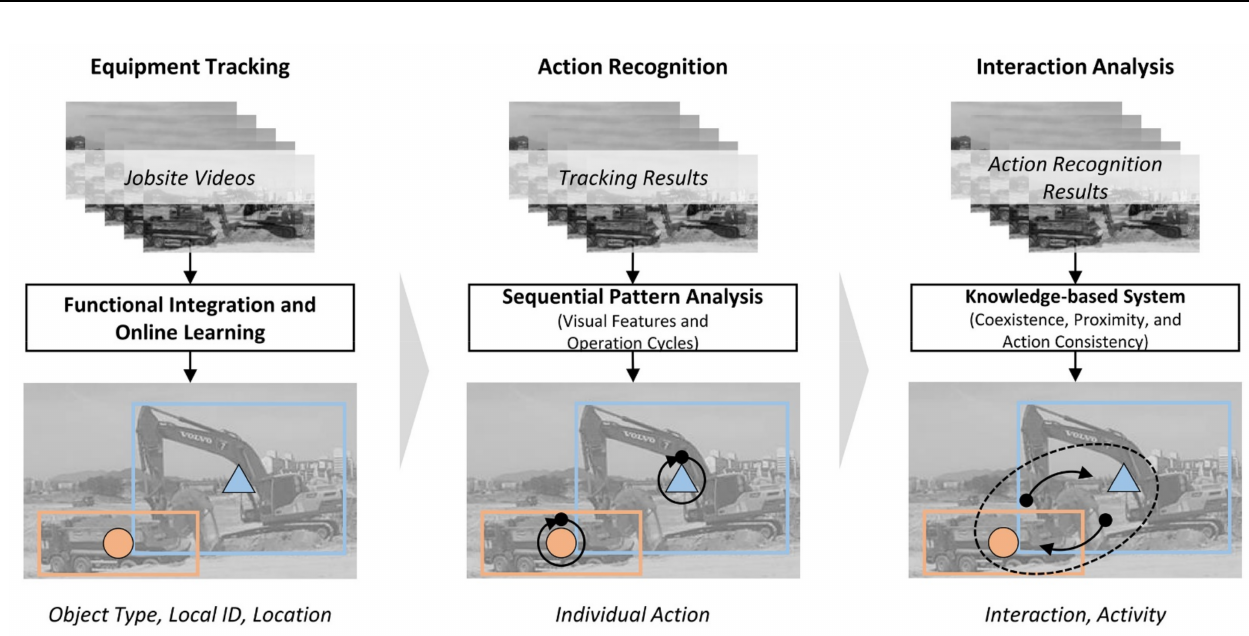
Figure 6. Equipment tracking, recognition and interaction analysis